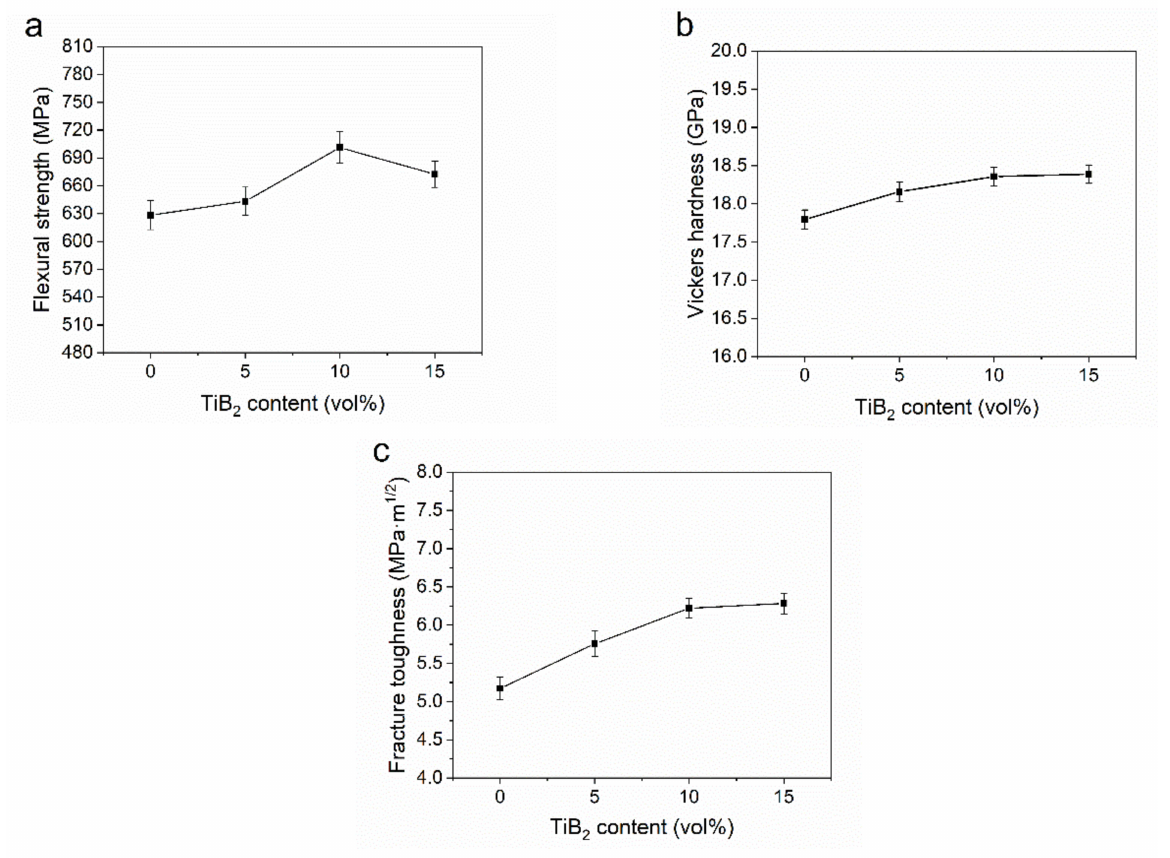
Figure 2. Effect of TiB 2 content on ( a ) flexural strength, ( b ) Vickers hardness, and ( c ) fracture toughness.